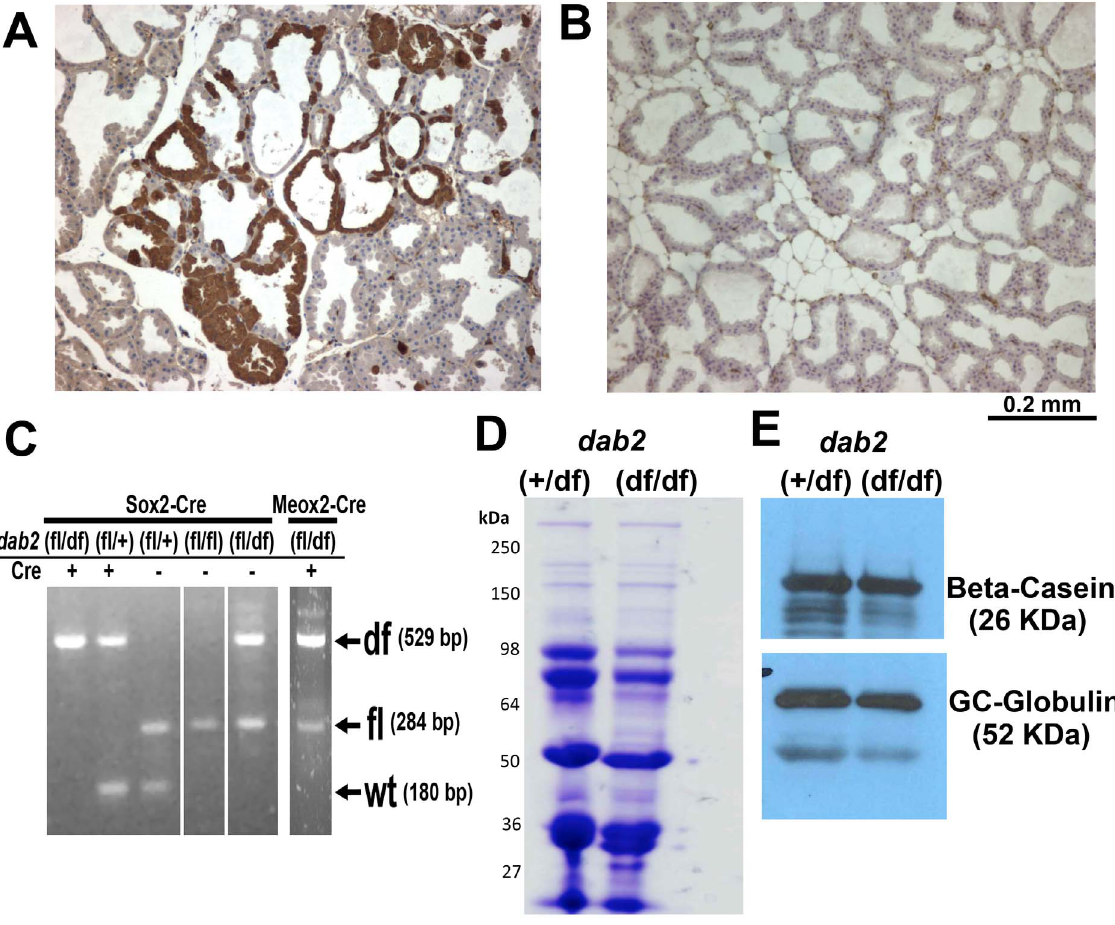
Figure 3. Normal lactation in mammary glands from dab2 mosaic knockout mice. ( A ) Mammary glands from 4-month old, 5-day lactating mice of dab2 (f/df):Meox2-Cre genotype show mosaic Dab2 immunostaining. ( B ) Dab2 was absent in more than 99% of mammary epithelial cells from mice of dab2 (f/df):Sox2-Cre genotype. ( C ) DNA extracted from tail tissues was used to genotype flox (f) and delta flox (df) alleles of the dab2 gene in dab2 ( + /df): Sox2-Cre, dab2 (f/df):Meox2-Cre, and dab2 (f/df):Sox2-Cre. ( D ) Milk was harvested from dab2 heterozygous ( dab2 ( + /df):Sox2-Cre) and knockout ( dab2 (f/df):Sox2-Cre) mice. Total proteins were resolved by SDS-PAGE and stained with Coomassie blue. ( E ) Specific proteins, beta- casein and GC-globin (vitamin D binding protein), were analyzed by